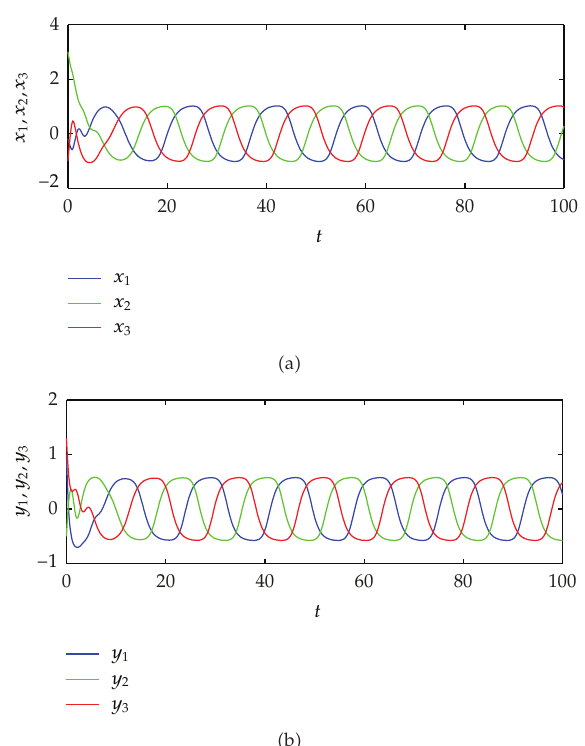
Figure 1: Two phase-locked oscillations: x 1 (cid:3) t (cid:4) (cid:8) x 2 (cid:3) t (cid:9) P T / 3 (cid:4) (cid:8) x 3 (cid:3) t (cid:9) 2 P T / 3 (cid:4) , y 1 (cid:3) t (cid:4) (cid:8) y 2 (cid:3) t (cid:9) P T / 3 (cid:4) (cid:8) y 3 (cid:3) t (cid:9) 2 P T / 3 (cid:4)